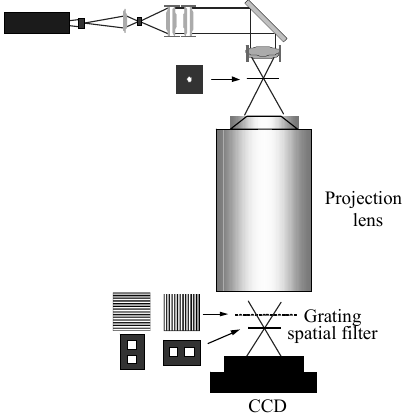
Fig. 1 Block diagrams of grating lateral shearing